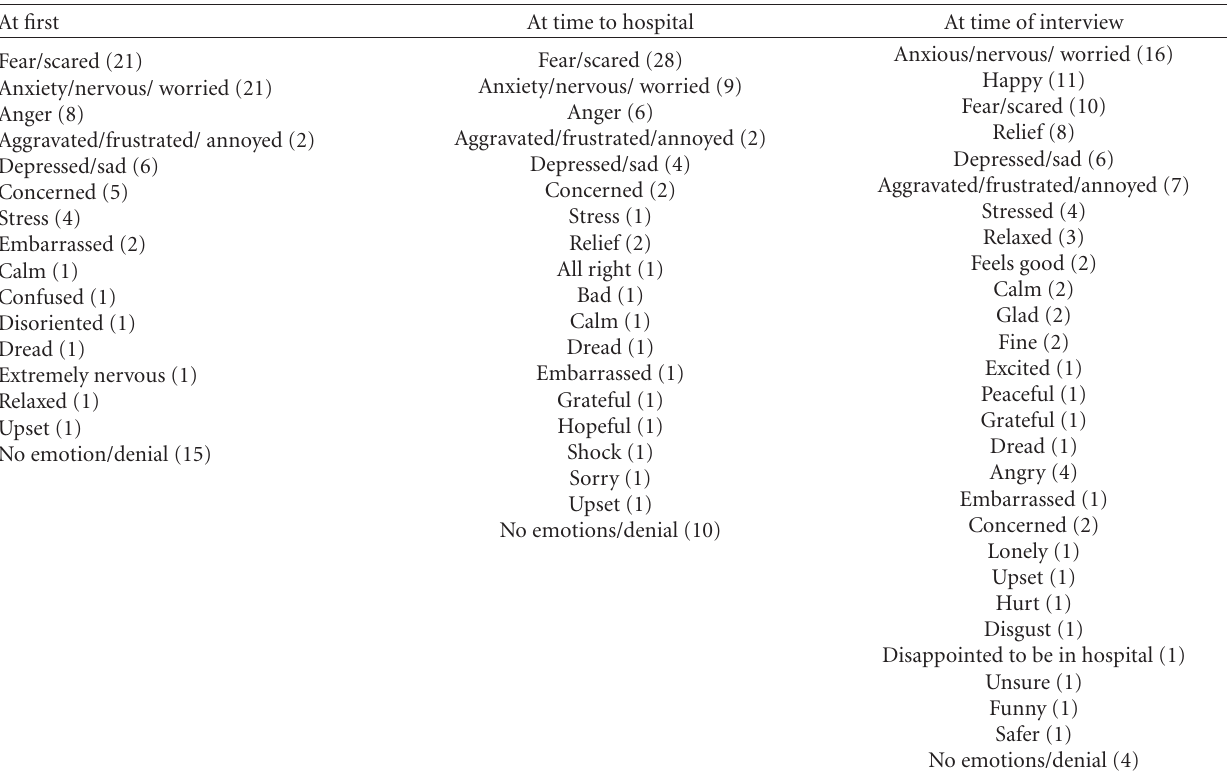
Table 3: Adjectives used to describe emotions by patients with suspected cardiac symptoms as a metric of commonality of experienced